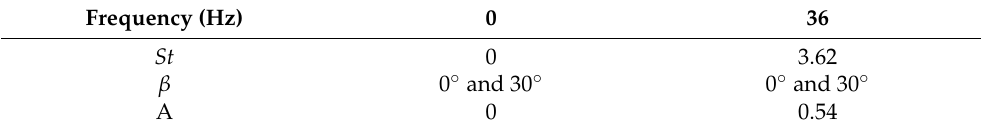
Table 2. Values in Equation (11) in terms of frequency and Strouhal number ( St ).